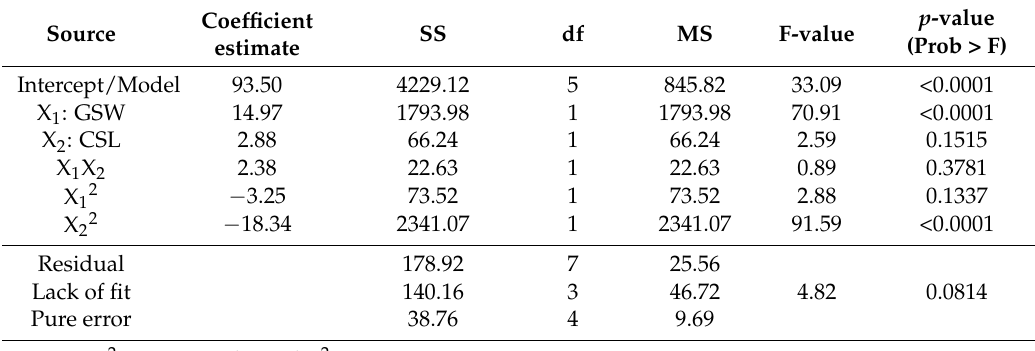
Table 4. Analysis of variance for the quadratic response surface